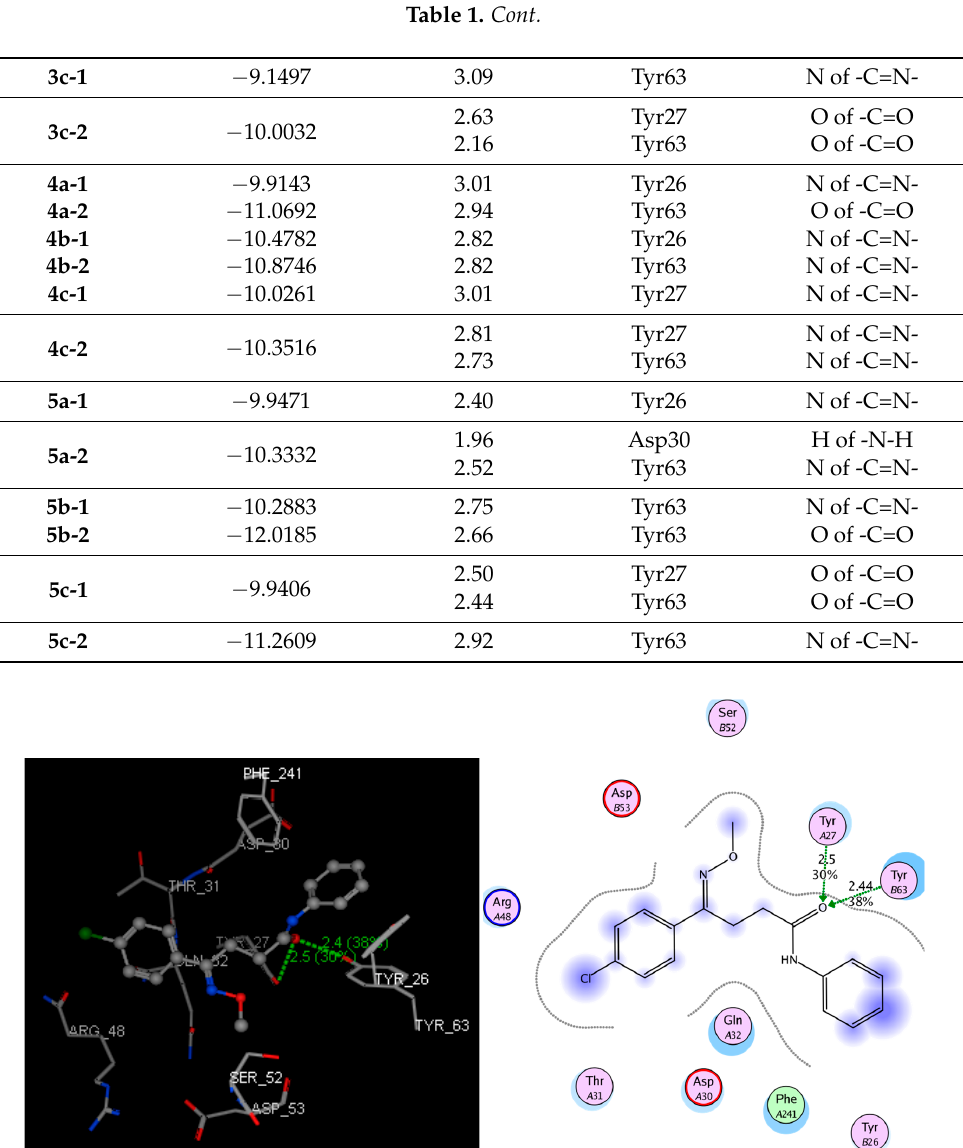
Figure 1. Binding mode of compound 5c-1 with 3OX8. The hydrogen bond formed is colored in green.